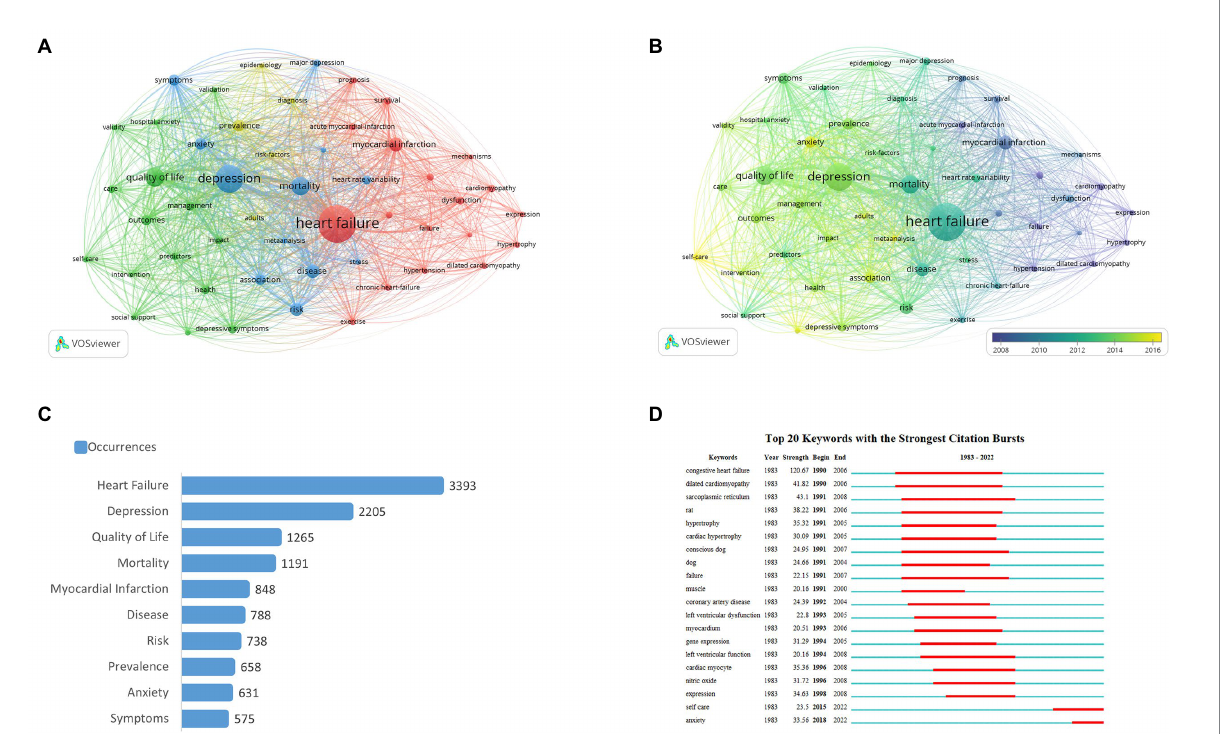
FIGURE 5 Notes: The size of each node represents the frequency of a keyword, while the link between nodes indicates the relationship between nodes, with the distance between them indicating the strength of the connection. The color indicates the co-occurrence of keywords (Figure 5A), while the color change indicates the time change of keywords (Figure 5B). ‘Begin’ and ‘End’ refer to the start and end of the keyword emergence, respectively. Strength is a measure of the intensity of the cited change. Red or blue bars represent time intervals. Red bars indicate bursts of citations (Figure 5D). (A) Network visualization map of keywords co-occurrences on heart failure and depression. (B) Network visualization map of the current tendency towards heart failure and depression based on keywords analysis. (C) Top 10 most frequent keywords. (D) Top 20 keywords with the strongest citations